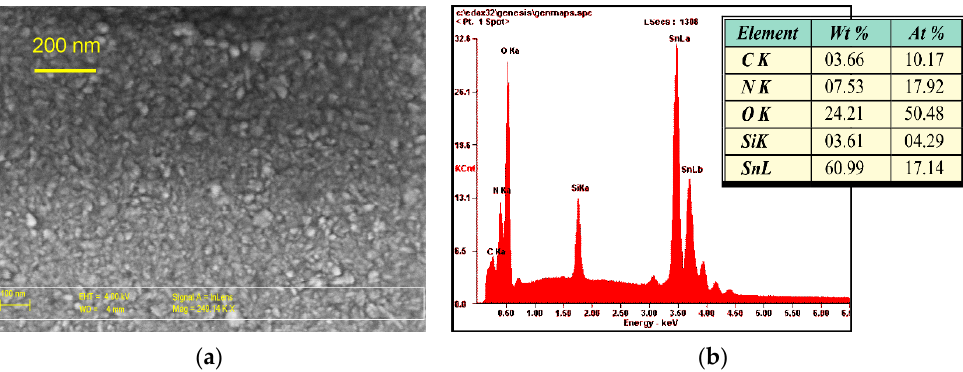
Figure 5. ( a ) SEM image of the MS-SnO 2 film surface (250,000×) of thickness d = 300 nm and ( b ) results of (SnO 2 ) microanalysis (qualitative and quantitative analysis).